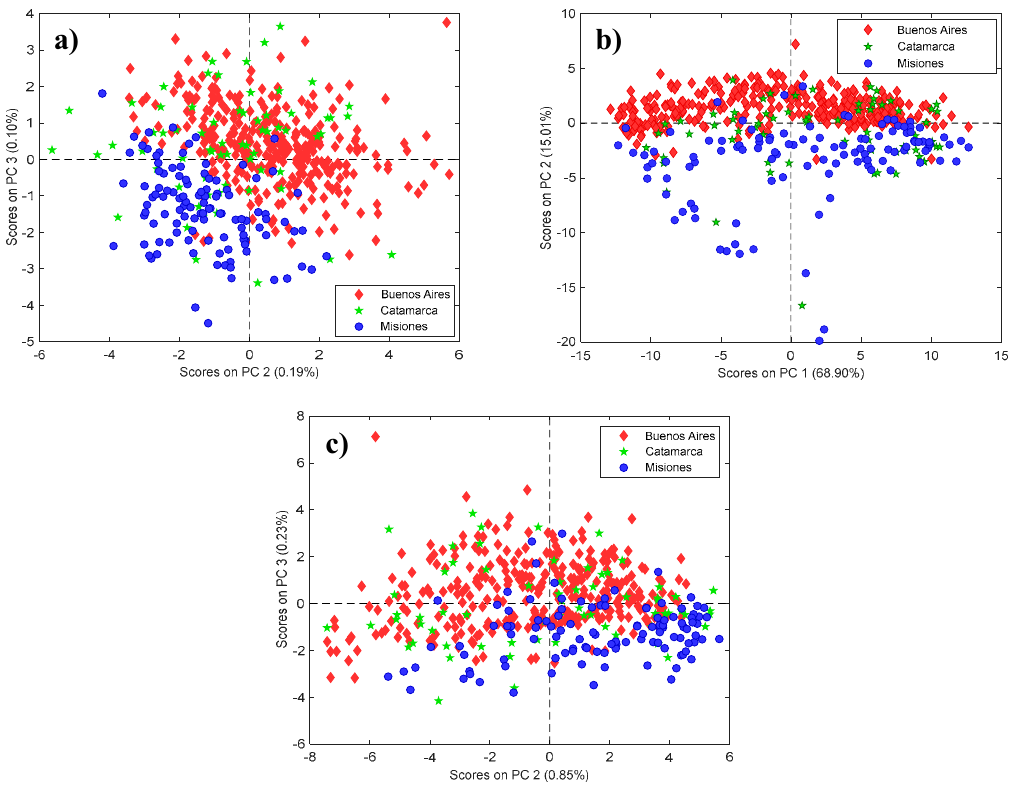
Figure 1. Scatter plot of PC1 vs PC2 scores obtained from FT-MIR ( a ), FT-Raman ( b ) and NIR ( c ) data. Objects are marked according to the provenance region (Red diamond: BA; Green star: Cat; Blue circle: Mis).